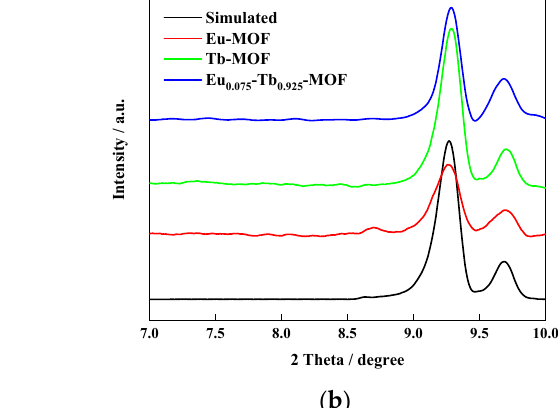
Figure 1. ( a ) XRD patterns of Ln-MOFs. ( b ) Enlarged version.